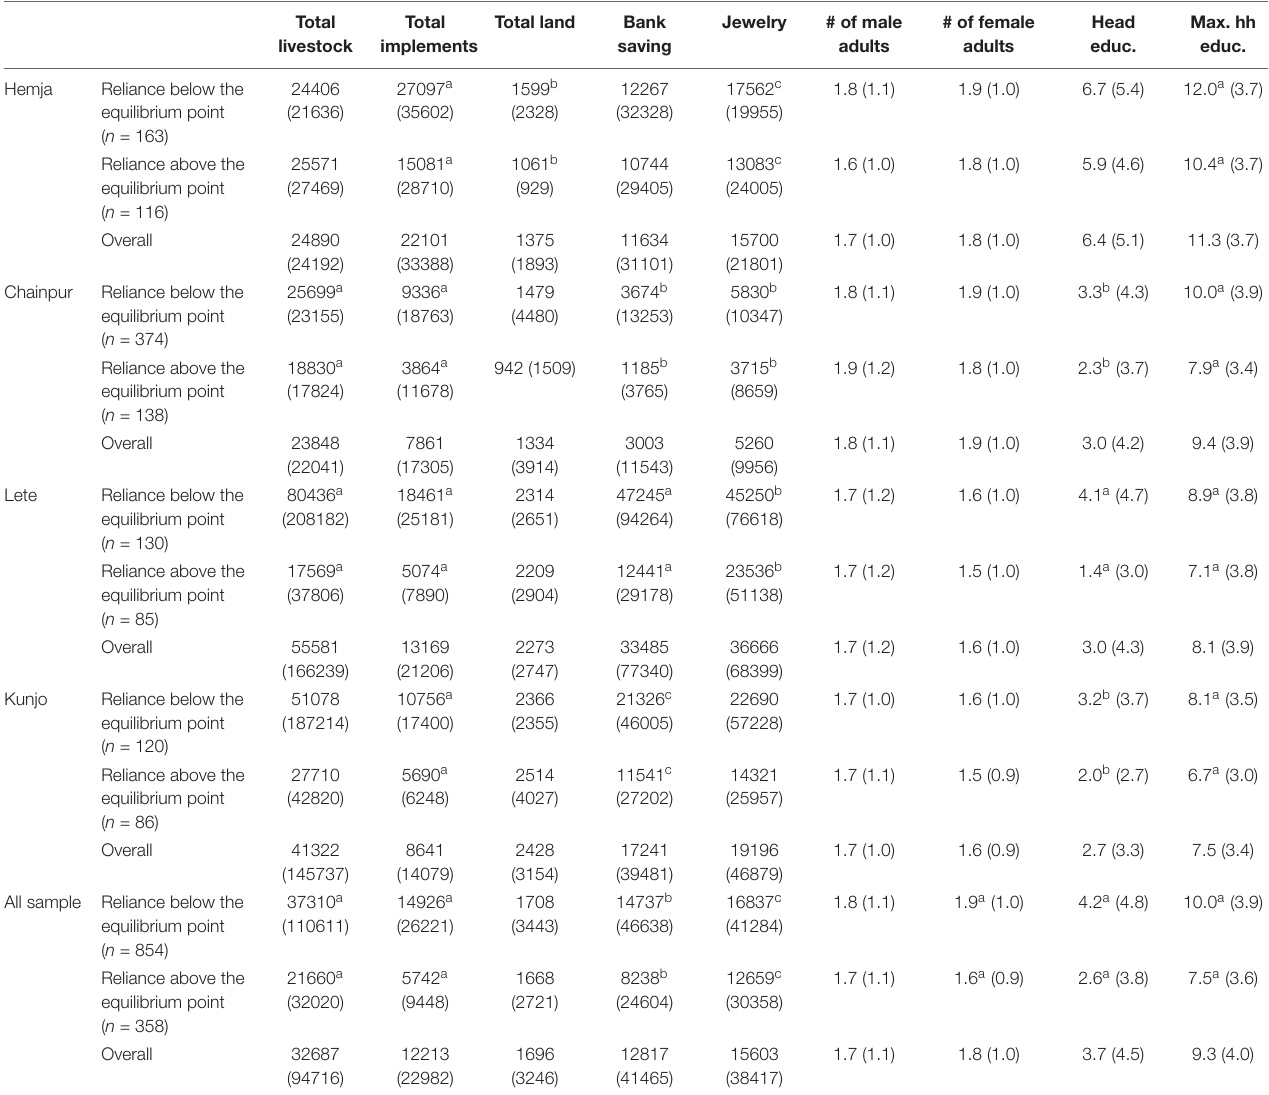
TABLE 3 | Household asset endowment (Nr/aeu in 2006 values) by asset type, site, and environmental reliance group, Nepal, 2006–2012; values in parenthesis are SD of the